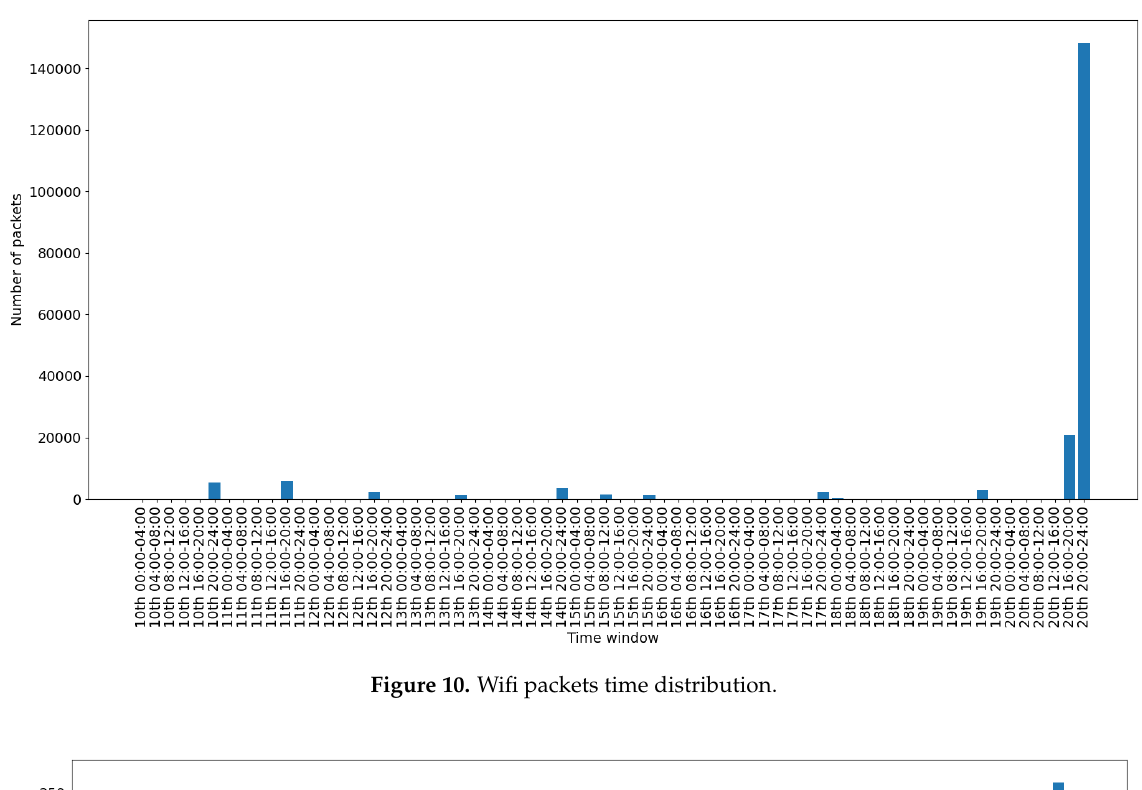
Figure 10. Wifi packets time distribution.